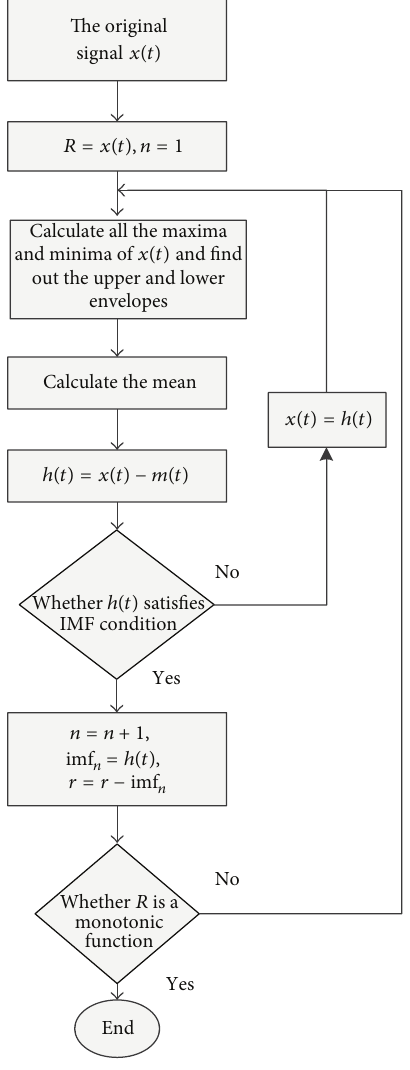
Figure 3: EMD decomposition